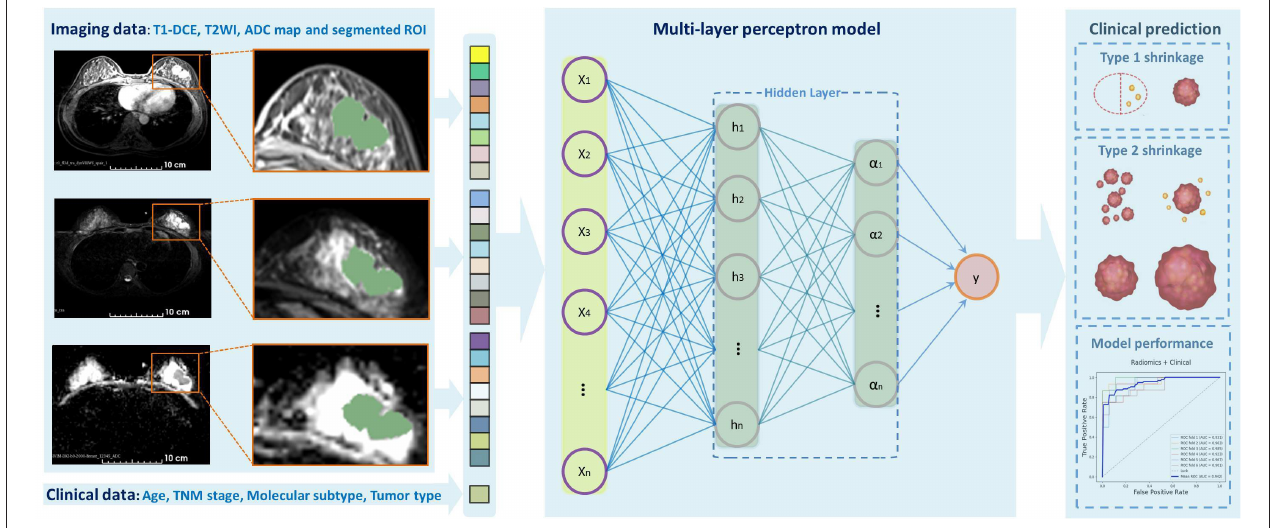
FIGURE 2 | Outline of the workflow from the data input, feature extraction, selection, model construction, and performance assessment.